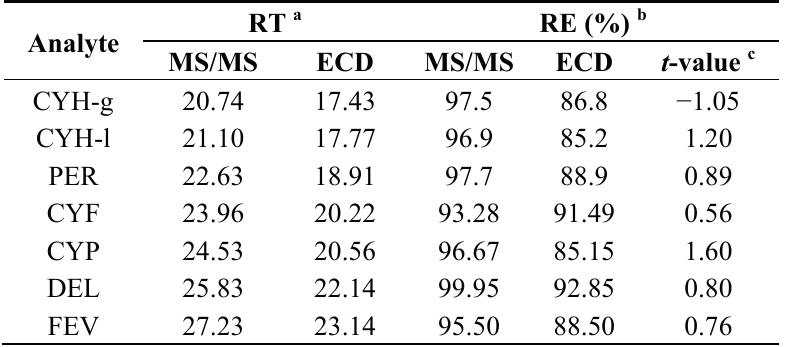
Table 4. Comparison data between chromatographic